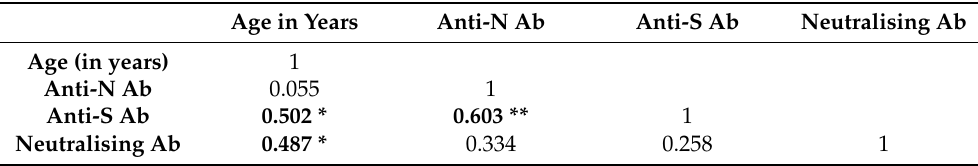
Table 3. Pearson’s correlation matrix of the age and antibodies (Ab) investigated in